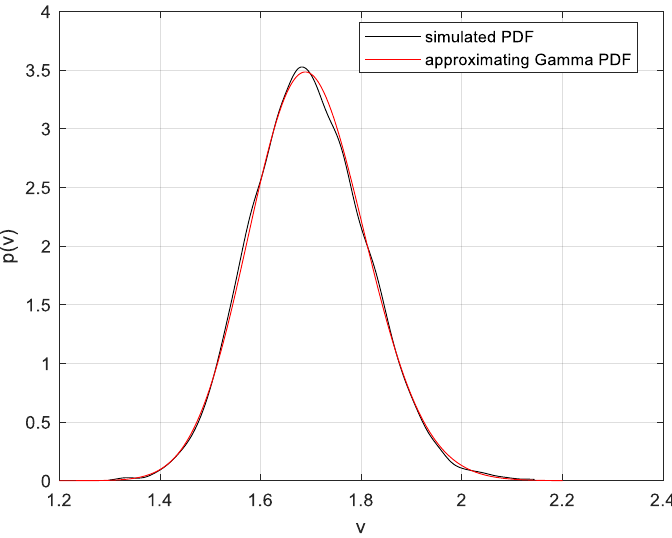
Figure 4. Two prior gamma PDFs for V are superimposed: the theoretical approximating prior gamma PDF of V and the one estimated from simulated data for case C11.